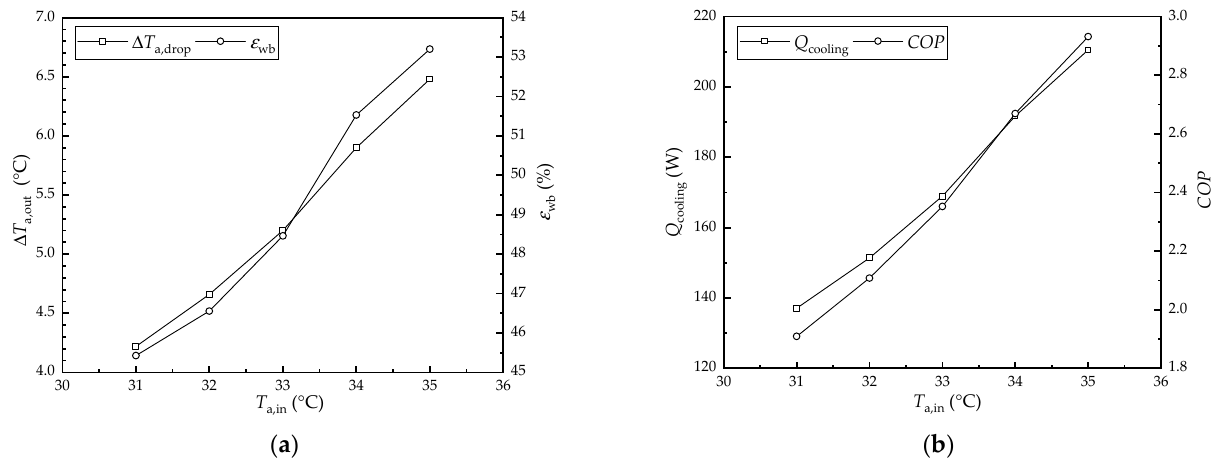
Figure 3. The effect of the inlet air temperature on the performance of the HFMEC: ( a ) air temperature drop and wet-bulb efficiency; ( b ) cooling capacity and COP .